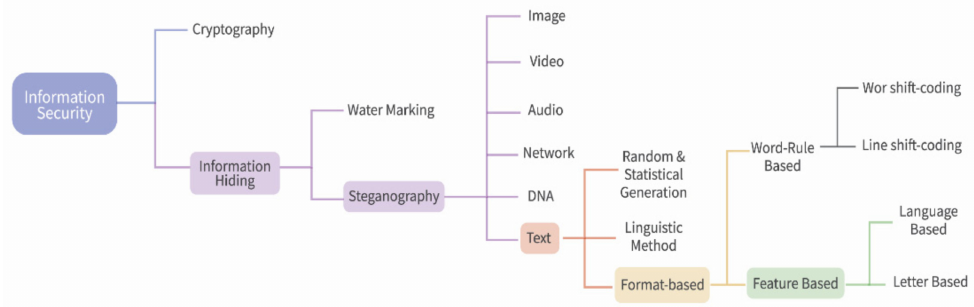
Figure 2. Classification of